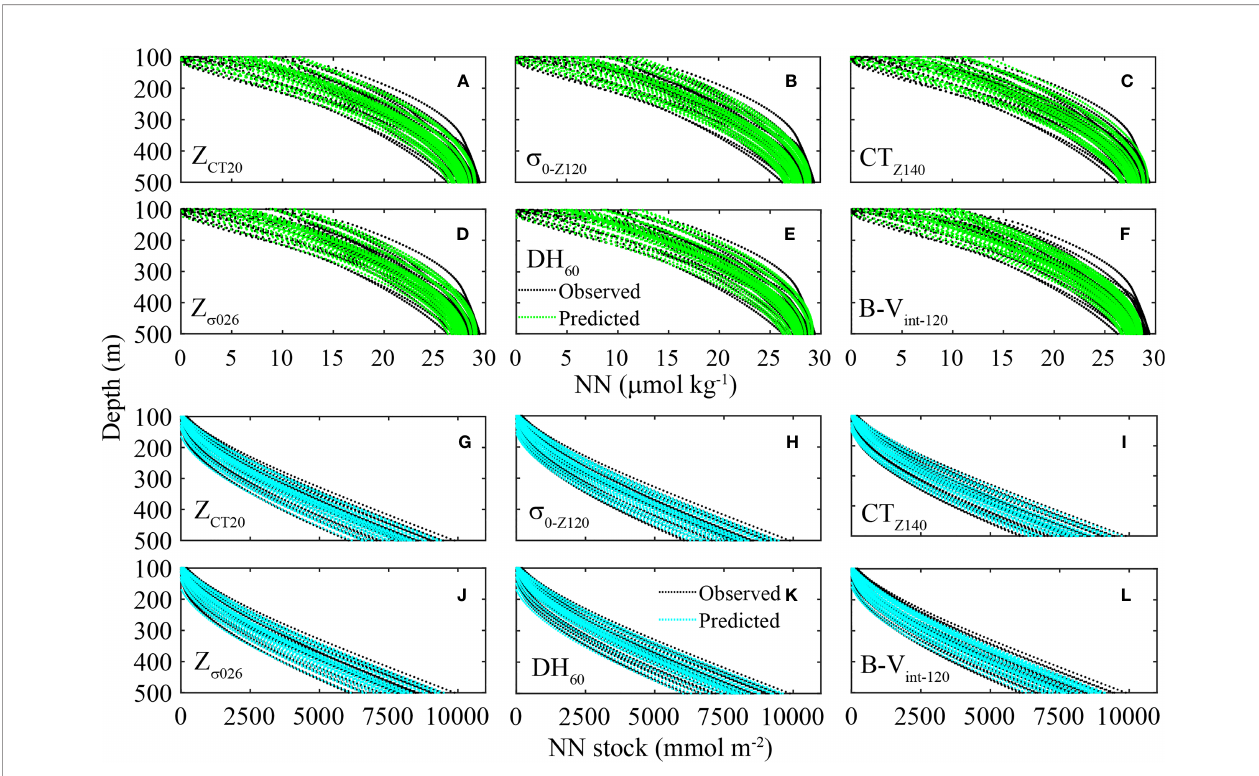
FIGURE 7 | Observed (black dots, ) and predicted (green dots , and cyan dots) NN values (µmol kg -1 ) in the interval of 100 – 500 m (A – F) and the NN stock (mmol m -2 ) (G – L) using the third degree polynomial fi t (Equations 1 – 3) for (A, G) the depth of the 20°C isotherm (Z CT20 , m), (B, H) potential density anomaly at 120 m ( s 0-Z120 , kg m -3 ), (C, I) Conservative Temperature at 140 m (CT Z140 , °C), (D, J) depth of the 26 kg m -3 isopycnal (Z s 026 , m), (E, K) integrated dynamic height between 1000 – 60 m (DH 60 , m 2 s -2 ), and (F, L) the integrated Brunt-Väisälä frequency between 15 – 120 m (B-V int-120 , m s -1 ) without Poseidon